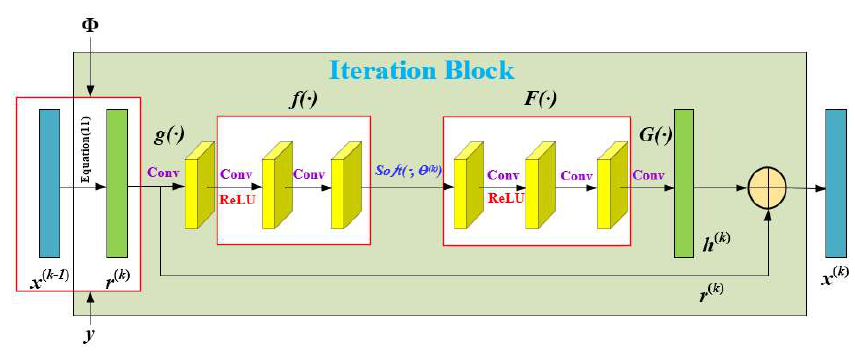
Figure 4. Structure diagram of the iteration block based on fully connected layer